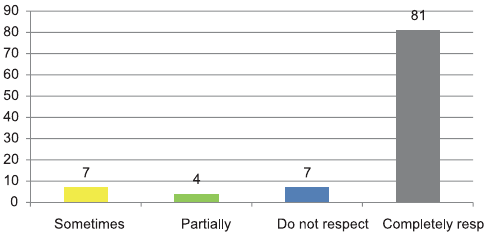
FIGURE 8. The presence of mobbing at work